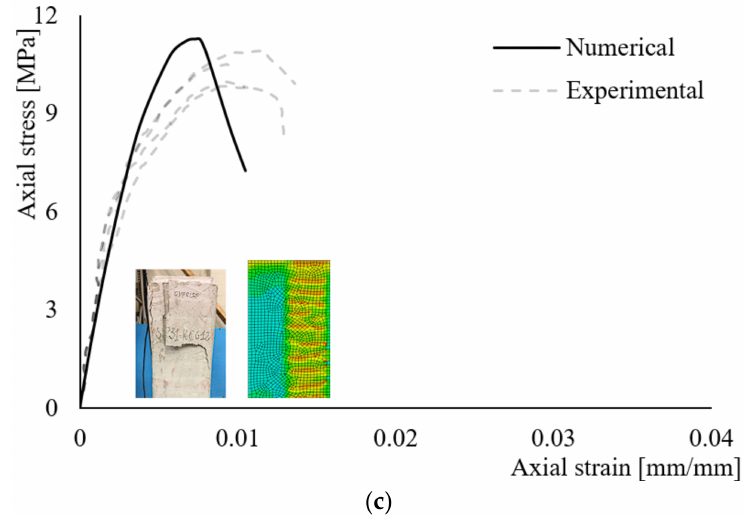
Figure 12. Comparison results for reinforced column between the numerical and experimental curve reported in Sneed et al. [68]: ( a ) Group 1, ( b ) Group 5, and ( c ) Group